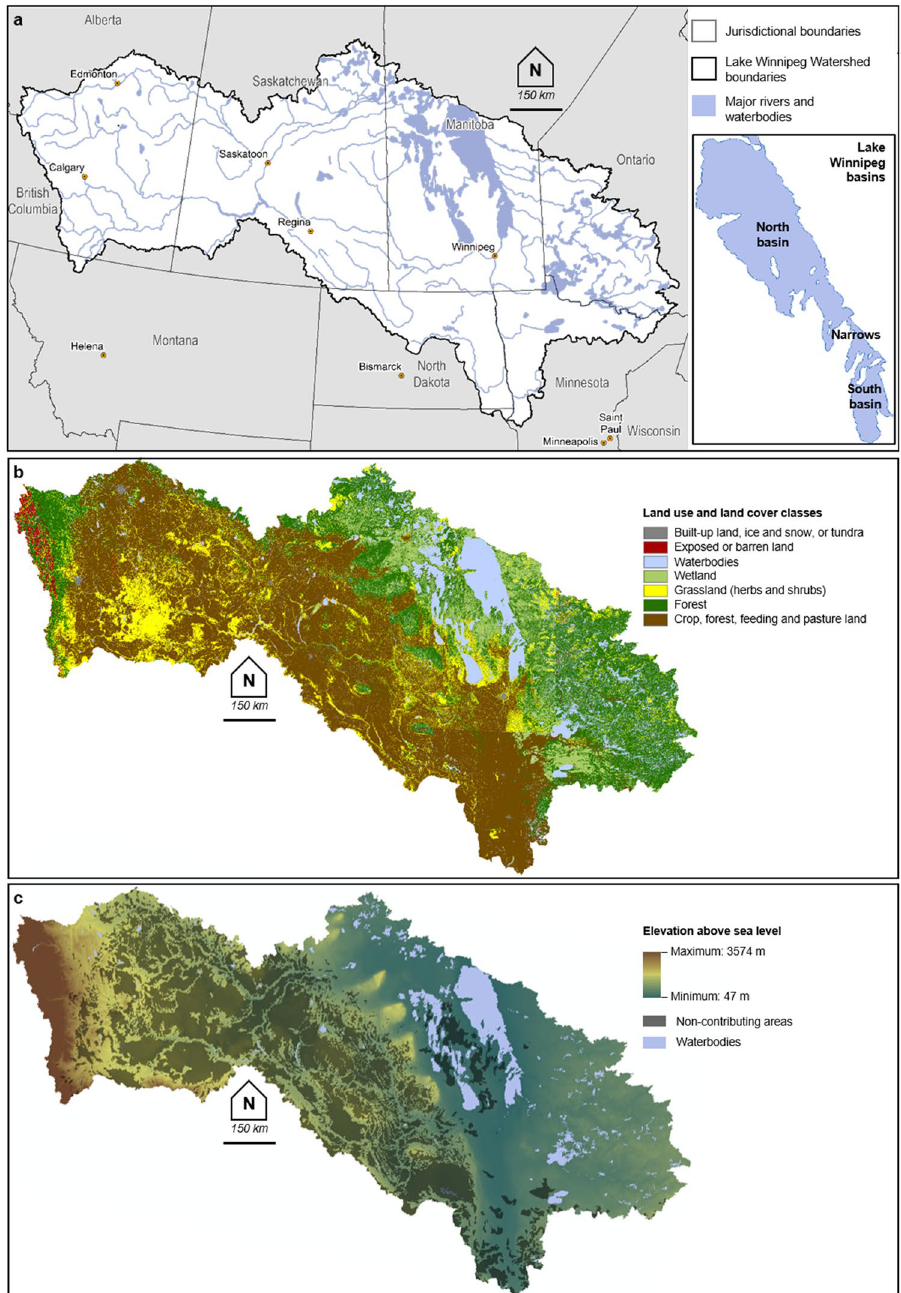
Figure 1. Lake Winnipeg Watershed characteristics. ( a ) Location of Lake Winnipeg, its watershed and its main rivers in North America. The north and south basins of the lake are identified. ( b ) Land use and land cover types across the watershed. ( c ) Elevation and (historically labelled) non-contributing areas across the watershed. Physiographic data (i.e., rivers and waterbodies, digital elevation data) and land use and land cover data were obtained from public repositories administered by the Government of Canada (see Methods) and mapped using the ArcGIS software (version 10.4.1,